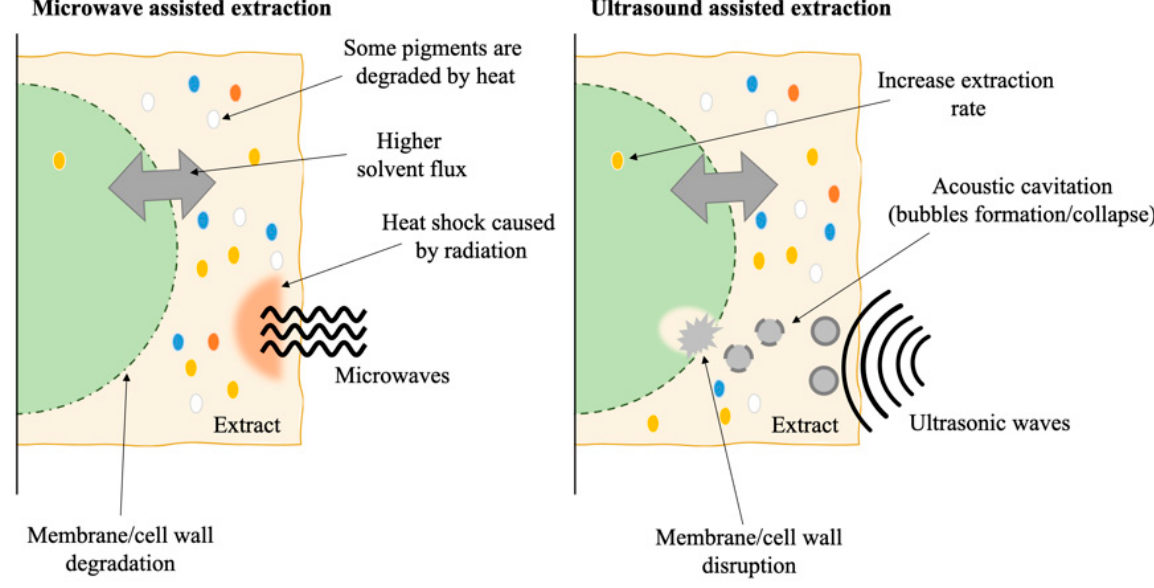
Figure 4. Schematic representation of microwave (MAE) and ultrasound assisted extraction (UAE) effects in microalgae and cyanobacteria cells.